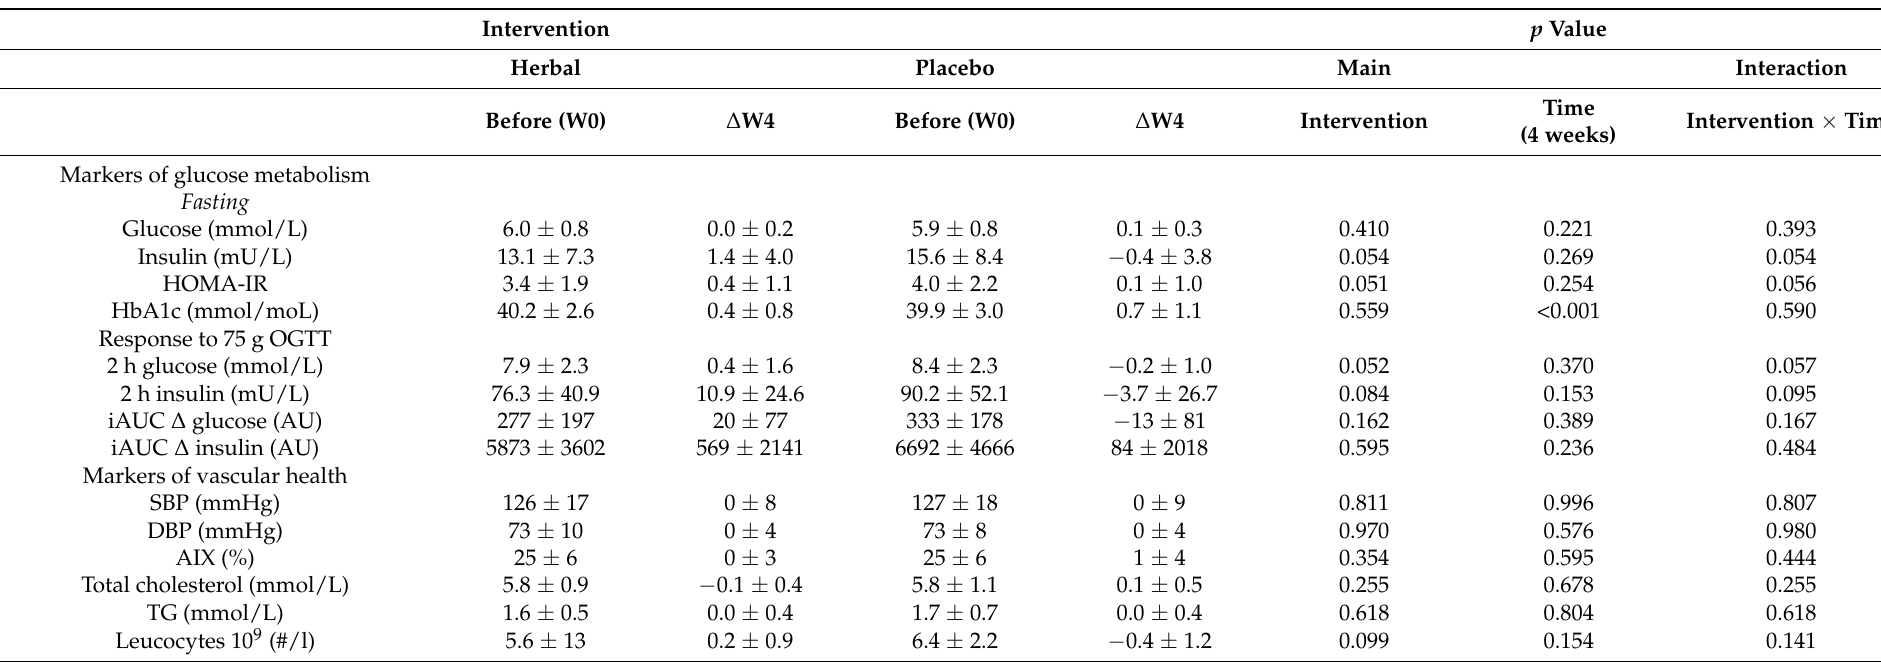
Values are mean ± SD, delta values are compared to baseline, n = 19, for SBP and DBP n= 18 and for AIX n = 15. P values were calculated by using linear mixed models for repeated measures. I, intervention effect; T, time effect; I x T, intervention x time interaction; OGTT, oral glucose tolerance test; iAUC, incremental area under the curve; SBP, systolic blood pressure; DBP, diastolic blood pressure; AIX, augmentation index; TG,